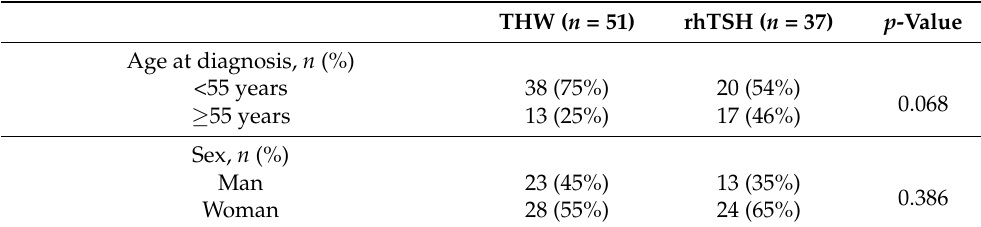
Table 1. General characteristics of patients with metastatic papillary thyroid cancer according to the preparation